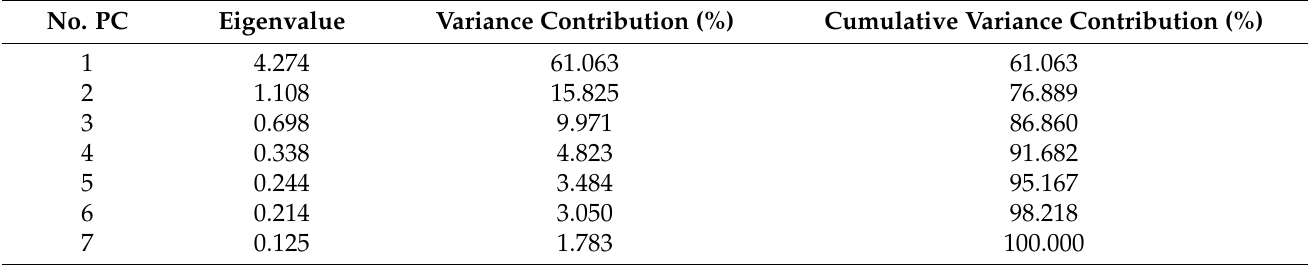
Table 4. Result for PCA.